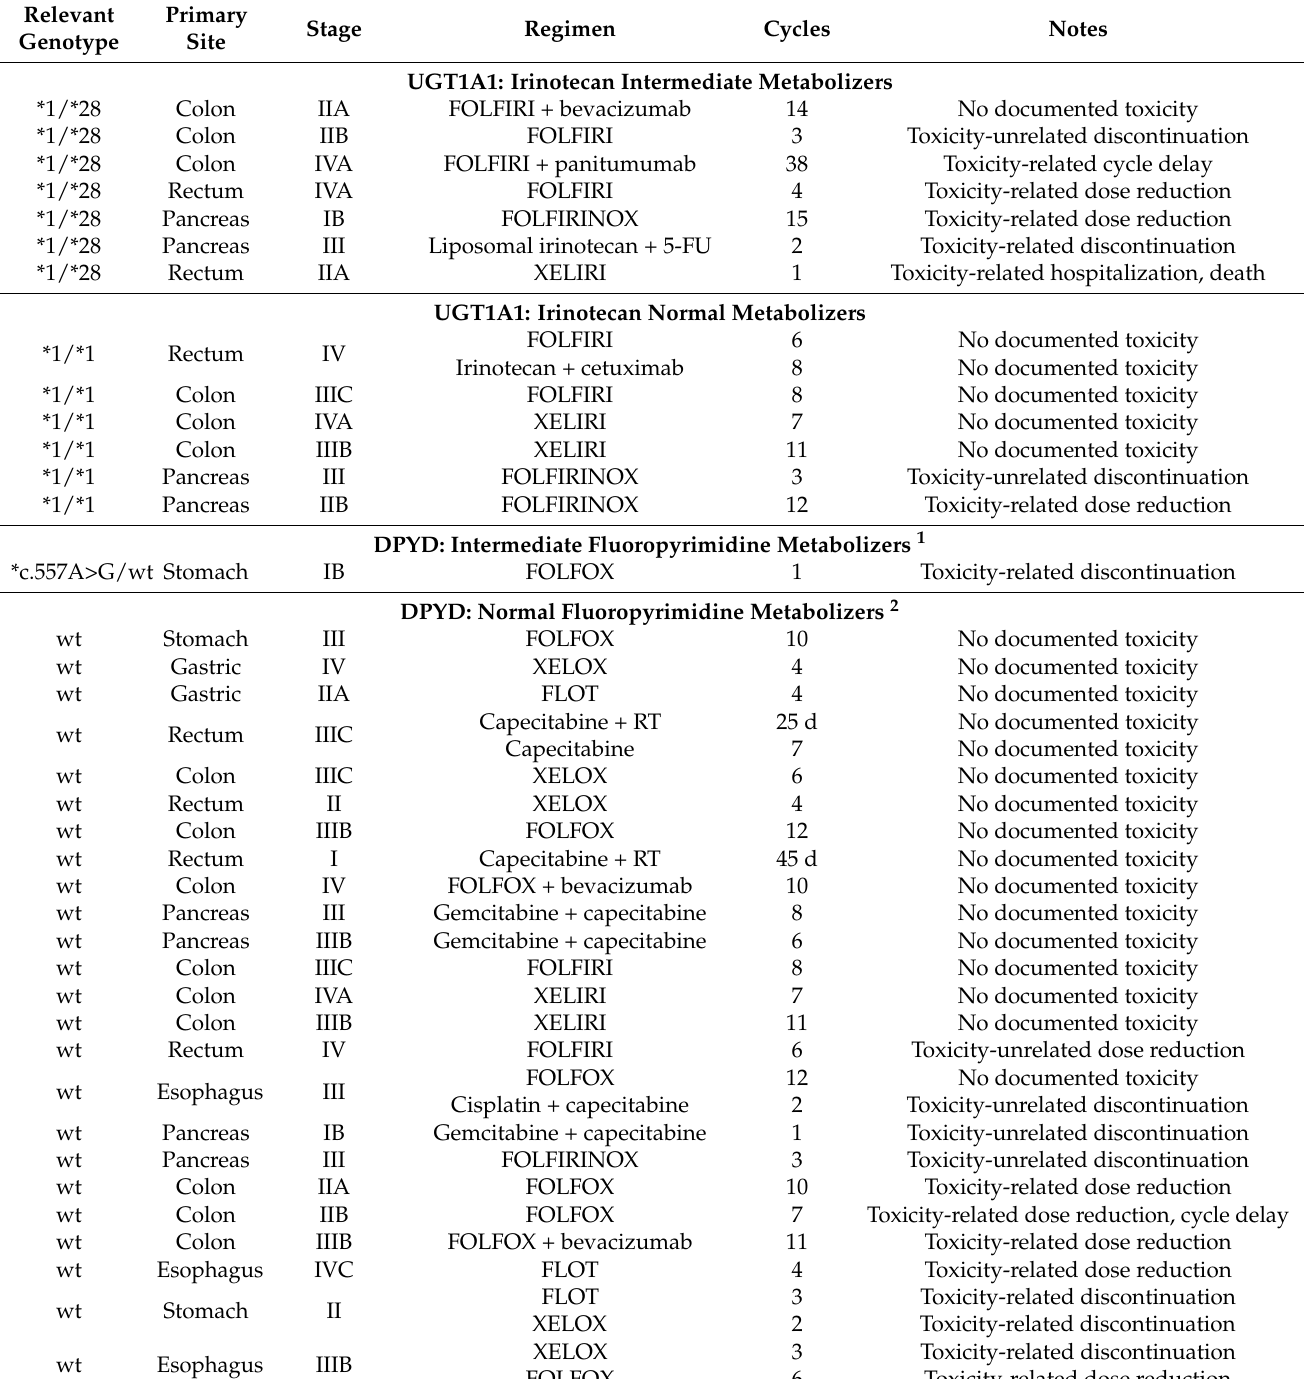
Table A2. Patient tolerance to genomically-relevant preferred anti-cancer agents by disease type. Toxicities resulting in dosing modifications, cycle delays, or discontinuation are reported. Dosing for each regimen is available in Appendix C. Only patients treated at our institution, for whom systemic treatment details were available, are reported. Irinotecan toxicities included cytopenia and diarrhea; fluoropyrimidine toxicities included cytopenia, diarrhea, hepatotoxicity, mucositis/stomatitis, and